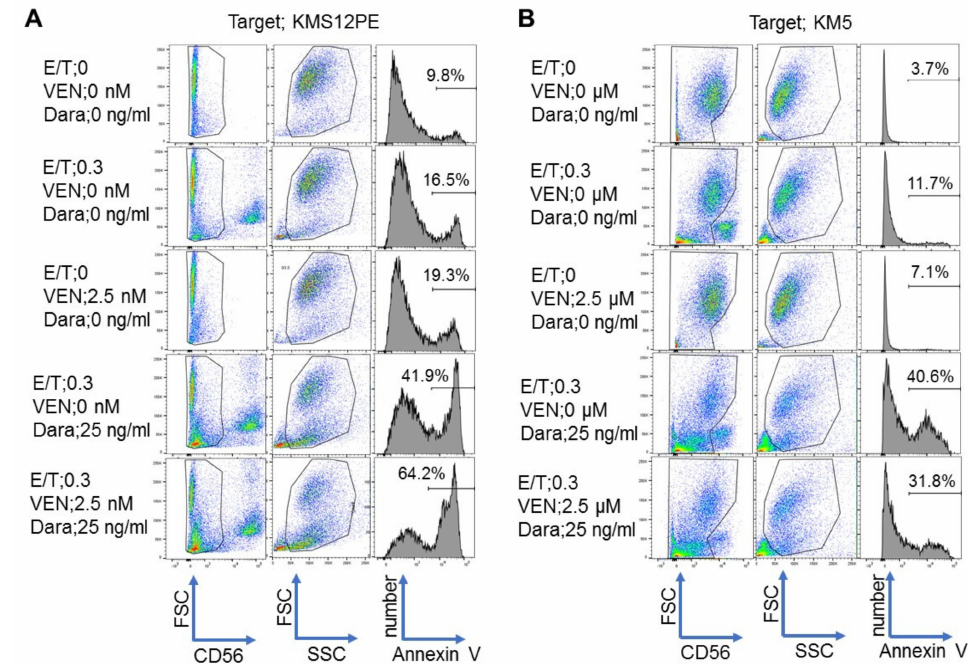
Figure 4. Representative flow cytometric analyses of cytotoxicity by NK cell- mediated ADCC with daratumumab and venetoclax to in MM cell lines using annexin V. The cytotoxicity of combining NK cell mediated ADCC with daratumumab and VEN to in KMS12PE ( A ) and KM5 ( B ) cells was investigated by flow cytometric analyses with annexin V. Cells were gated on forward scatter (FSC) and CD56 to remove NK cells, and the gated cells were separated by forward scatter (FSC) and side scatter (SSC). Annexin V+ cells in gated cells separated by FSC and SSC were detected. The percentage of Annexin V+ cells is indicated in each histogram. Cell treatment conditions are indicated on the left side of each panel. E/T: effector/target, VEN: venetoclax, Dara: daratumumab. These experiments were repeated three times in each cell line, and the average value with standard deviation (SD) has been shown (Figure 5). A synergistic effect was observed in KMS12PE and KMS27, which are sensitive to venetoclax, but not in U266 and KM5, which are resistant to